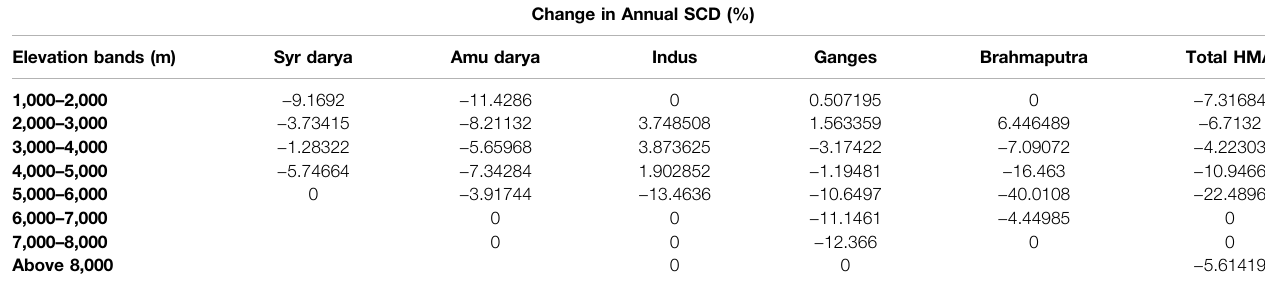
TABLE 2 | Slope of annual SCD per elevation band for each basin and the total HMA region, including the percent change in annual SCD. Elevation bands